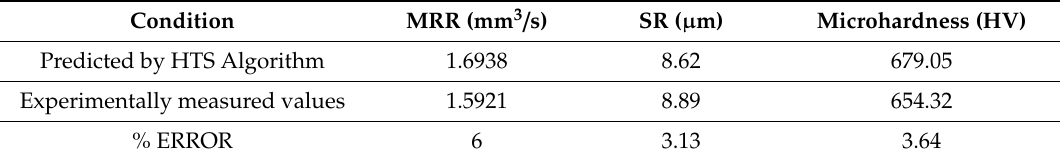
Table 5. Validation results for case study II.